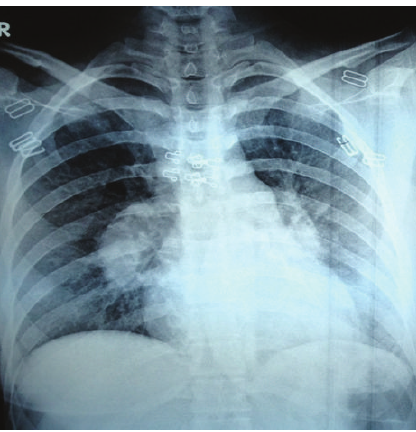
Figure 1: Chest radiogram demonstrating bilateral hilar enlarge- ment and patchy